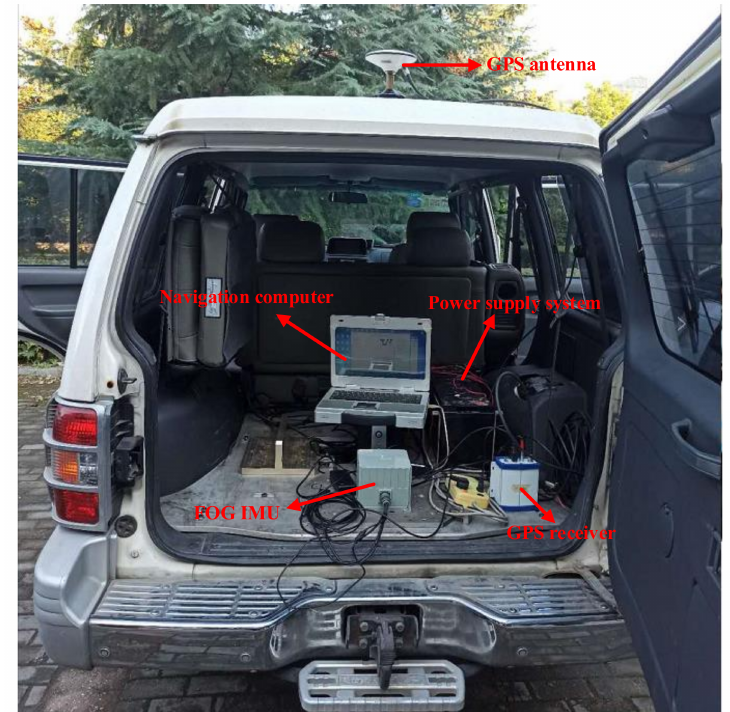
Figure 10. Setup of the experimental